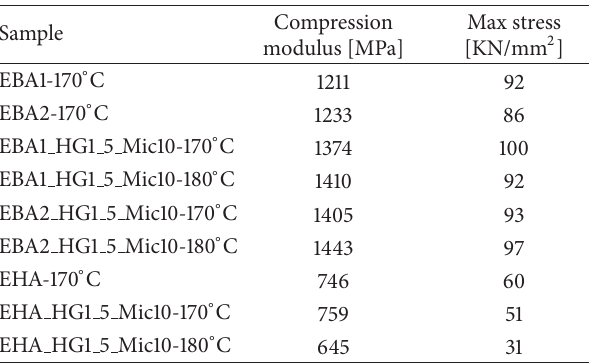
Table 2: The compressive modulus